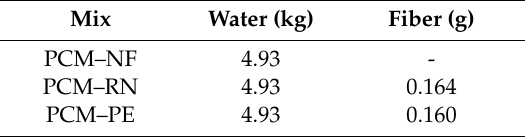
Table 3. Mix proportion of PCM (in 25 kg of PCM).